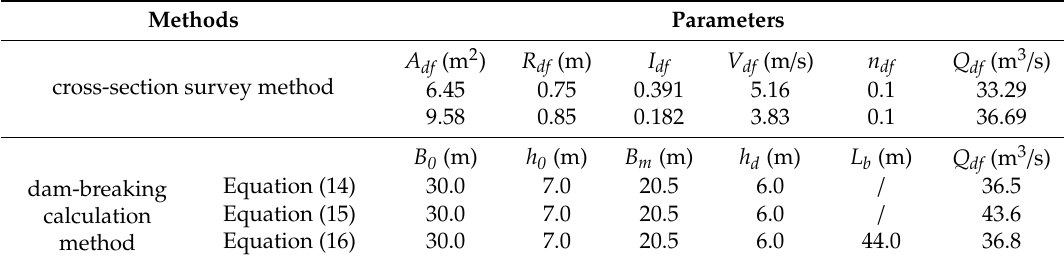
Table 2. Calculation results of the debris flow peak discharge by using the cross-section survey method and dam-breaking calculation